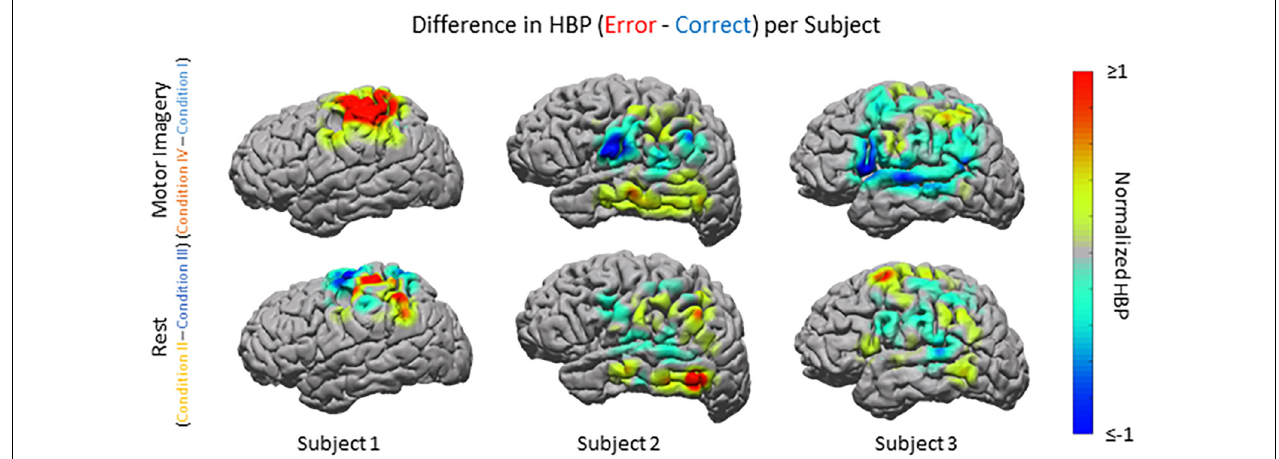
FIGURE 5 | HBP during correct and erroneous BCI decoder performance per individual subject. Difference in high-gamma power during correct and error epochs 100–500 ms after error onset for each subject. Top row shows power of Condition IV–Condition I, bottom row shows power of Condition II–Condition III. Heat maps were scaled to visualize the most robust